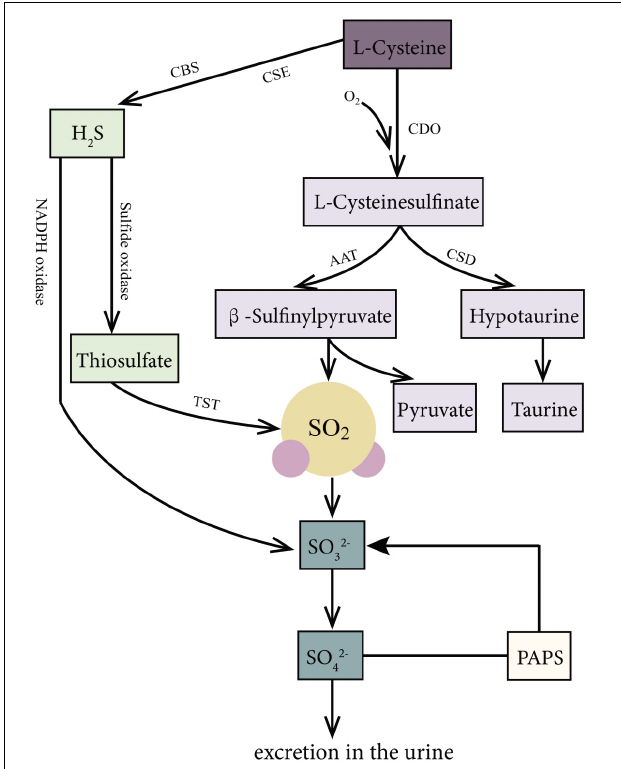
FIGURE 1 | Production and metabolism of endogenous SO 2 in mammals. L-Cys is metabolized through important enzymes including CDO, AAT, and CSD to generate endogenous SO 2 , pyruvic acid, and hypotaurine. Moreover, H 2 S, a product of the reaction catalyzed by CSE and CBS with L-Cys as substrate, can be metabolized to sulfite or SO 2 via the catalyzation of sulfide oxidase, TST, and NADPH oxidase. Thirdly, PAPS in activated neutrophils is also an origin of sulfite. In mammals, SO 2 can be hydrated to sulfite, then converted into sulfate by sulfite oxidase, and finally excreted in the urine in the kidney. AAT: aspartate aminotransferase; CBS, cystathionine β -synthase; CDO, cysteine dioxygenase; CSE, cystathionine γ -lyase; L-Cys, L-cysteine; NADPH, nicotinamide dinucleotide phosphate; PAPS, 3 (cid:48) -phosphoadenosine-5 (cid:48) -phosphosulfate; TST, thiosulfate